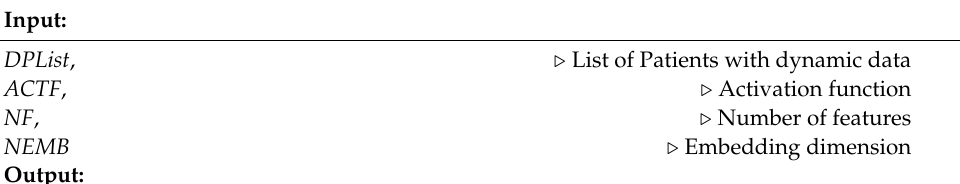
Algorithm 2. Dynamic data similarity evaluation